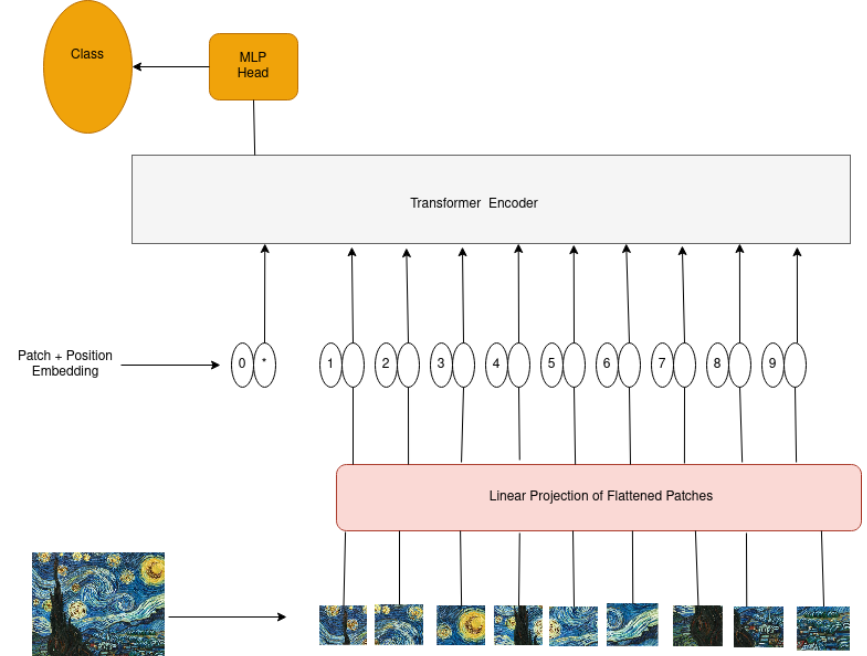
Figure 1. ViT model overview.